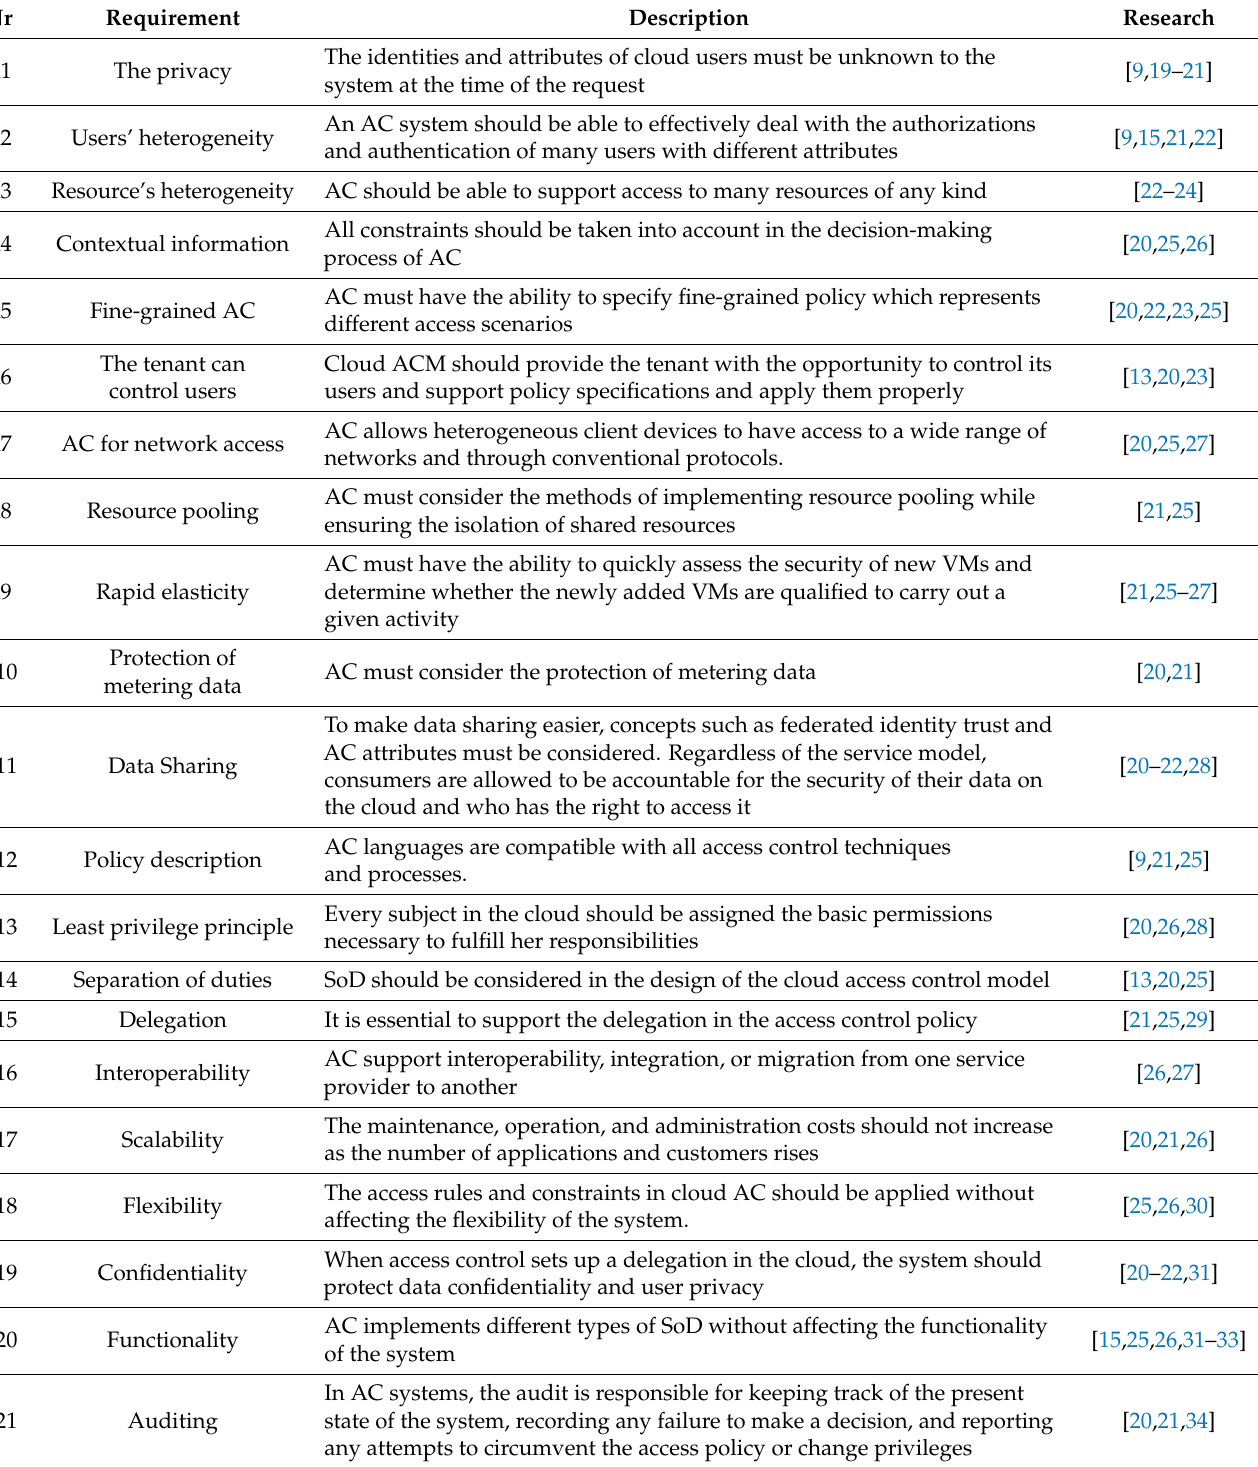
Table 1. Requirements included in the